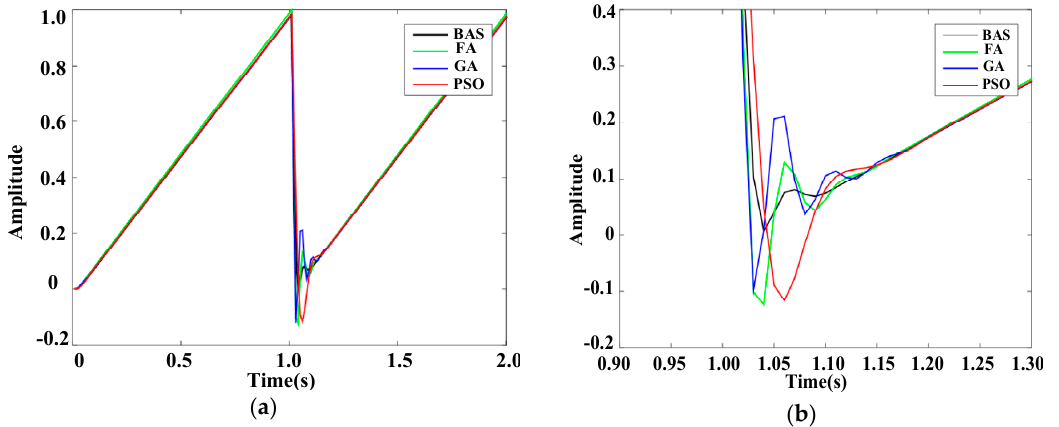
Figure 8. Response curves of the sawtooth wave signal. ( a ) Whole response curves. ( b ) Local amplification curves.